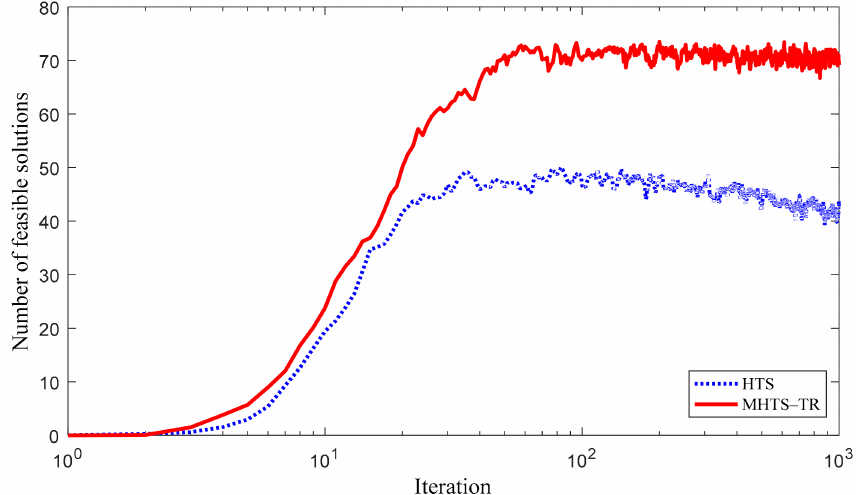
Figure 5. The number of feasible solutions obtained by the original HTS and MHTS–TR algorithms on benchmark function